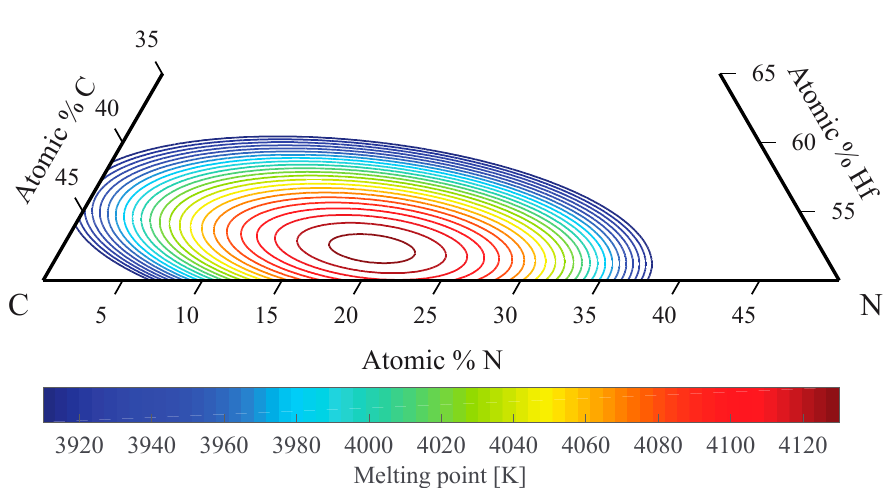
Figure 5. Melting temperatures of Hf-C-N alloys, based on density functional theory (DFT) calculations. Melting temperature maximum is located at Hf 0.53 C 0.27 N 0.20. Modified after Hong and van de Walle [1].